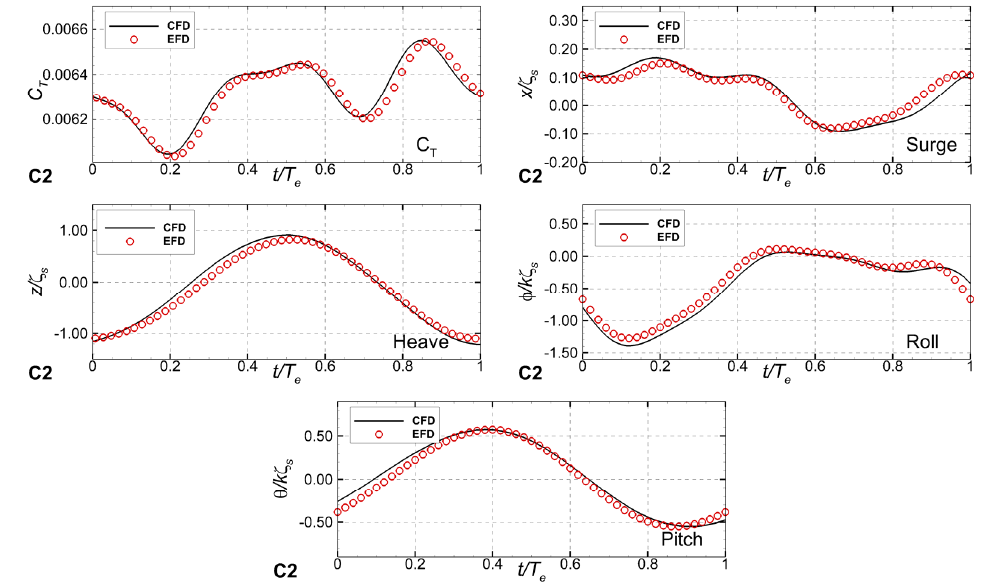
Figure 18. Comparisons between the time histories of the reconstructed resistance coefficient (𝐶 (cid:3021) ), surge ( x ) , heave ( z ) , roll ( ϕ ) , and pitch ( θ ) measured (EFD) [33] and computed (CFD) over a period of the encounter wave in the FRxz ϕθ bow waves scenario.